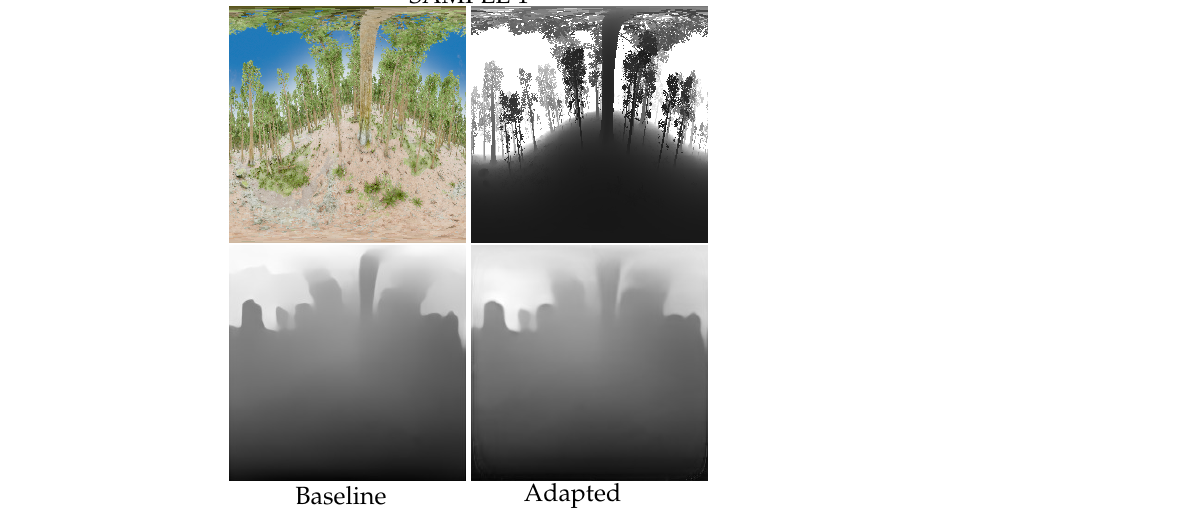
Figure A1. Prediction examples in the RWFOREST dataset. The predicted depth images are visually challenging to compare. However, quantitative measurements have shown that the adapted version is numerically better than the baseline. Top left: RGB input, top right: ground-truth monocular depth, bottom left: prediction from the baseline network, bottom right: prediction from the adapted network.